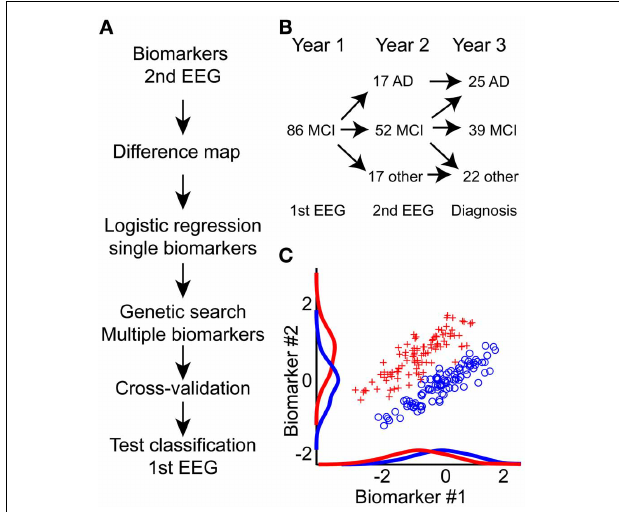
FIGURE 1 | An integrative approach toward improved prediction of mild cognitive impairment to Alzheimer’s disease conversion. (A) Diagram of processing flow. We calculate biomarkers on the second year EEG recording; hereafter we mapped all potential differences between MCI and AD using Student’s t -test (Difference map). Next, we performed logistic regression on each single biomarker. Biomarkers with best single-classification power were seeded to a genetic search algorithm; this algorithm further optimized the combined biomarker set. This biomarker set was then used to predict MCI to AD conversion based on the first-year EEG recording. To evaluate the lower bound on the classification, half-split cross-validation was performed. Finally, the outcome performance was evaluated on the 1st EEG recording. (B) Overview of how the MCI patient cohort splits into AD, another diagnosis, or remain MCI one or 2 years after the in-take. (C) The integration of multiple biomarkers can reveal hidden separation boundaries. Here, we show two simulated biomarkers where the red and blue groups are overlapping if we only consider the single biomarkers. By combining the biomarkers, we see a clear separation boundary at the diagonal. Classification algorithms aim to identify this boundary, and use it to predict group association for new